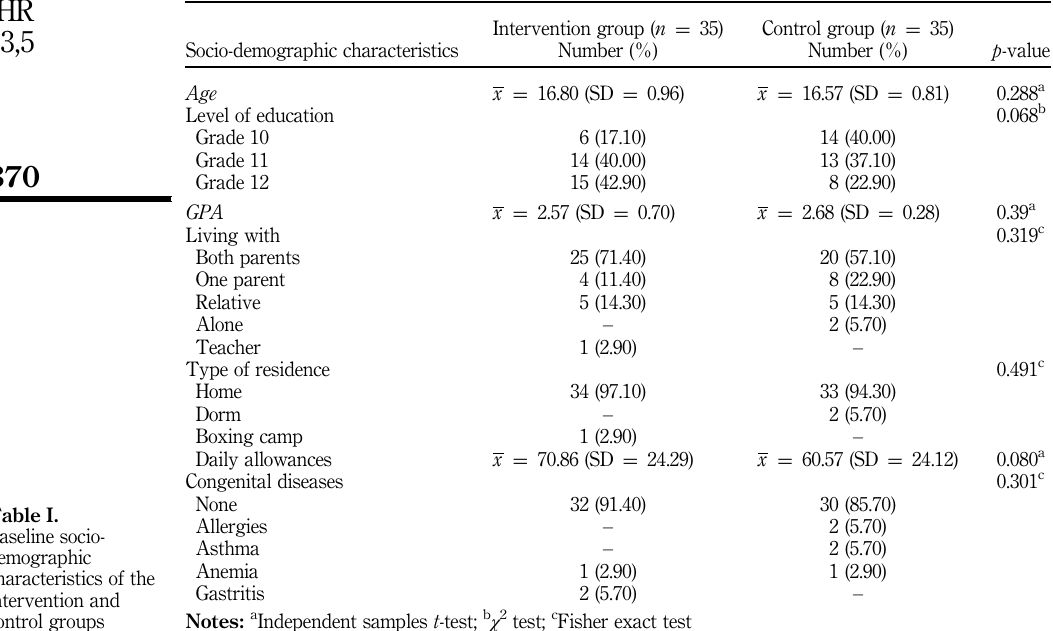
Table I. Baseline socio- demographic characteristics of the intervention and control